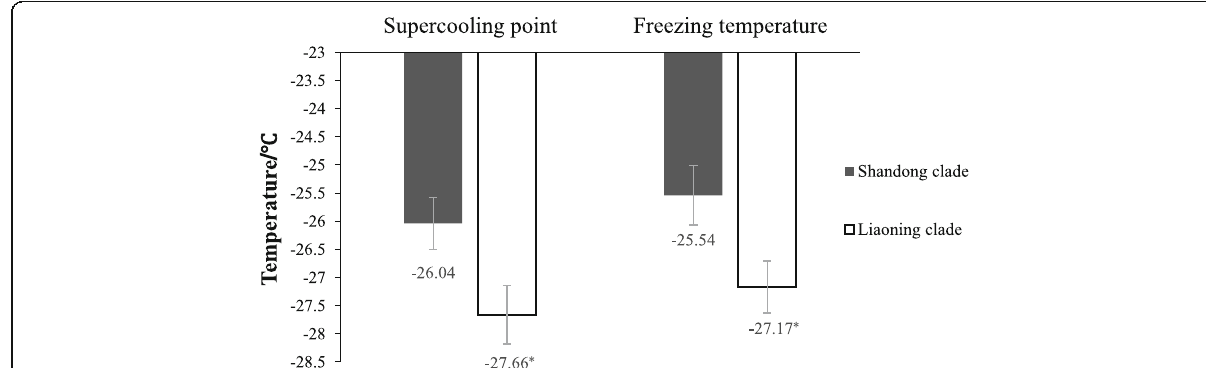
Fig. 1 Supercooling and freezing points of overwintering Aphelinus mali larvae for two genetic clades found in China. Asterisk indicates a significant difference at the 0.05